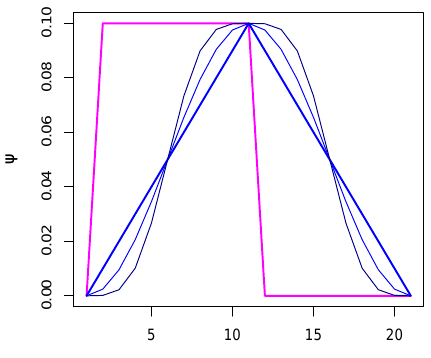
Fig. 1. Range integration averaging kernels used in the calcula- tions. The boxcar kernel (magenta) was not used in the subsequent calculations. The triangle kernel (thick blue) seemed to perform best while the sin-shaped kernel (thin blue) and the iterated sin- shaped kernel (dark blue) performed slightly worse. The results corresponding to the last three kernels are shown with correspond- ingly colored curves in the